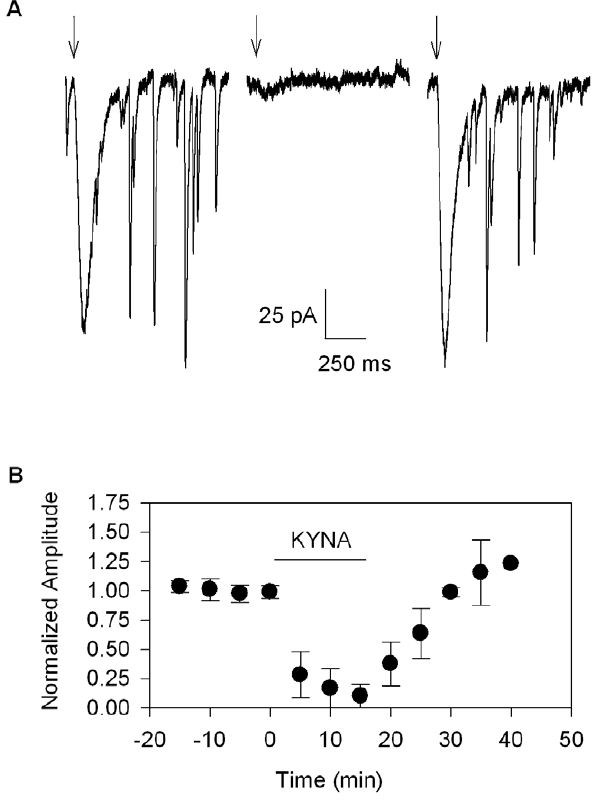
Figure 2. KYNA effects on exogenously applied glutamate- induced whole-cell currents. Panel A shows representative traces for whole-cell currents evoked by pressure-applied glutamate (arrows; 100 m M glutamate, 2–10 psi, 10–100 ms). Panel B shows the combined results (t=8.8502, df=4, p , 0.001, n=5, paired t-test).